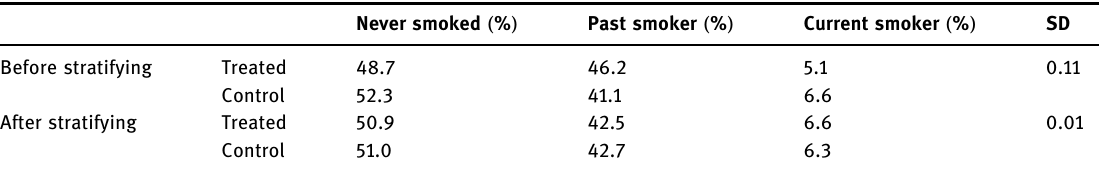
Table A3: Standardized di ff erences ( SD ) between treated and control populations in the observational database, before and after strati fi cation on the propensity score, for smoking